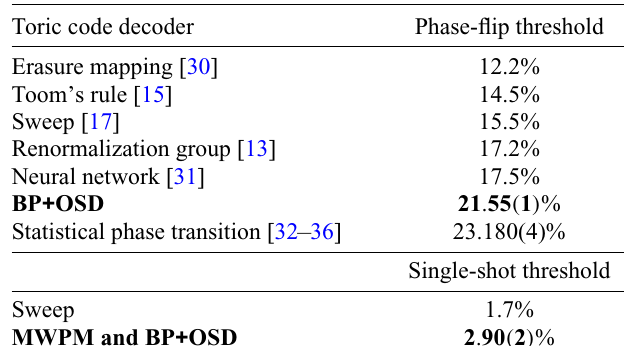
TABLE I. Comparison of the error thresholds of toric code decoders (results from this work are highlighted in bold). For phase-flip noise, BP+OSD outperforms all prior art, and approaches the theoretical upper bound given by mapping to a statistical mechanical model. In the single-shot regime, MWPM and BP+OSD outperforms the Sweep decoder (the theoretical maximum is unknown in this case).